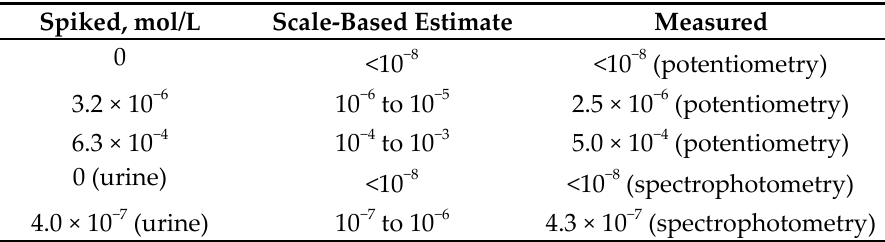
Table 1. The results of Pb 2+ determination in aqueous and diluted urine